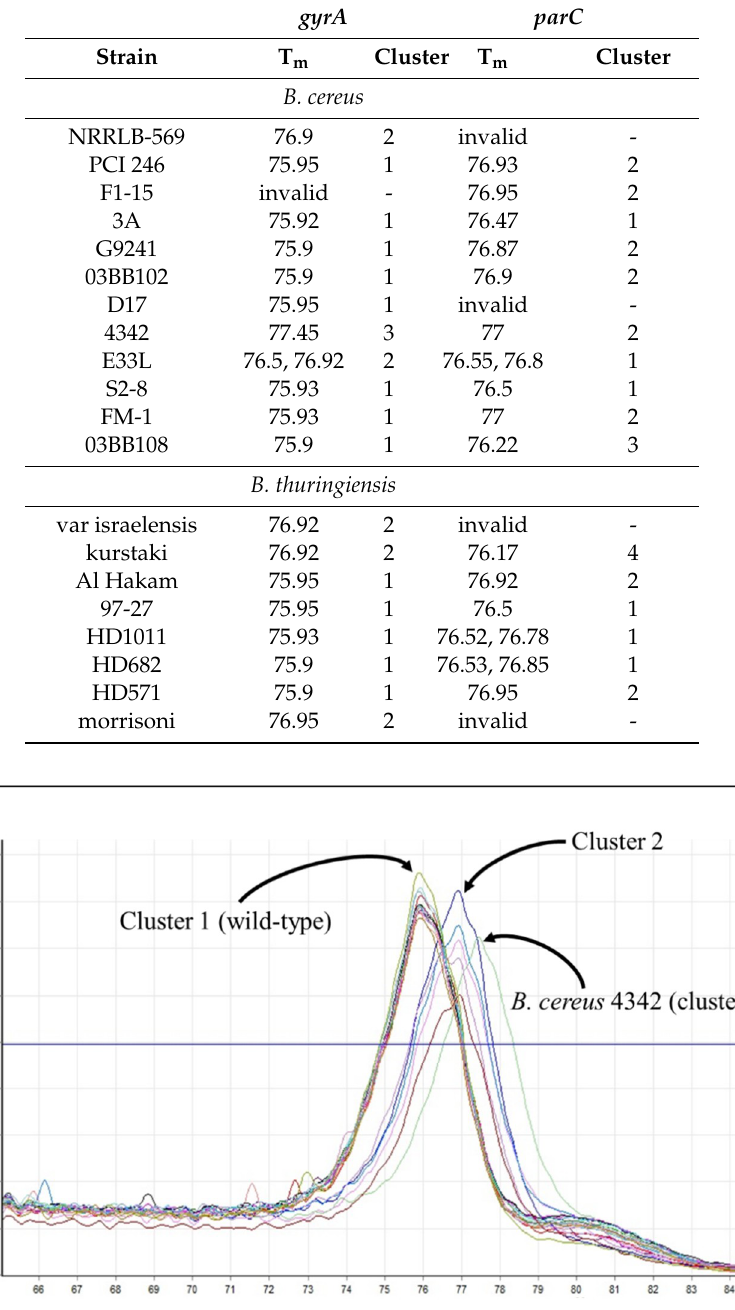
Table 7. HRMA melt temperatures and clusters for B. cereus and B. thuringiensis strains.